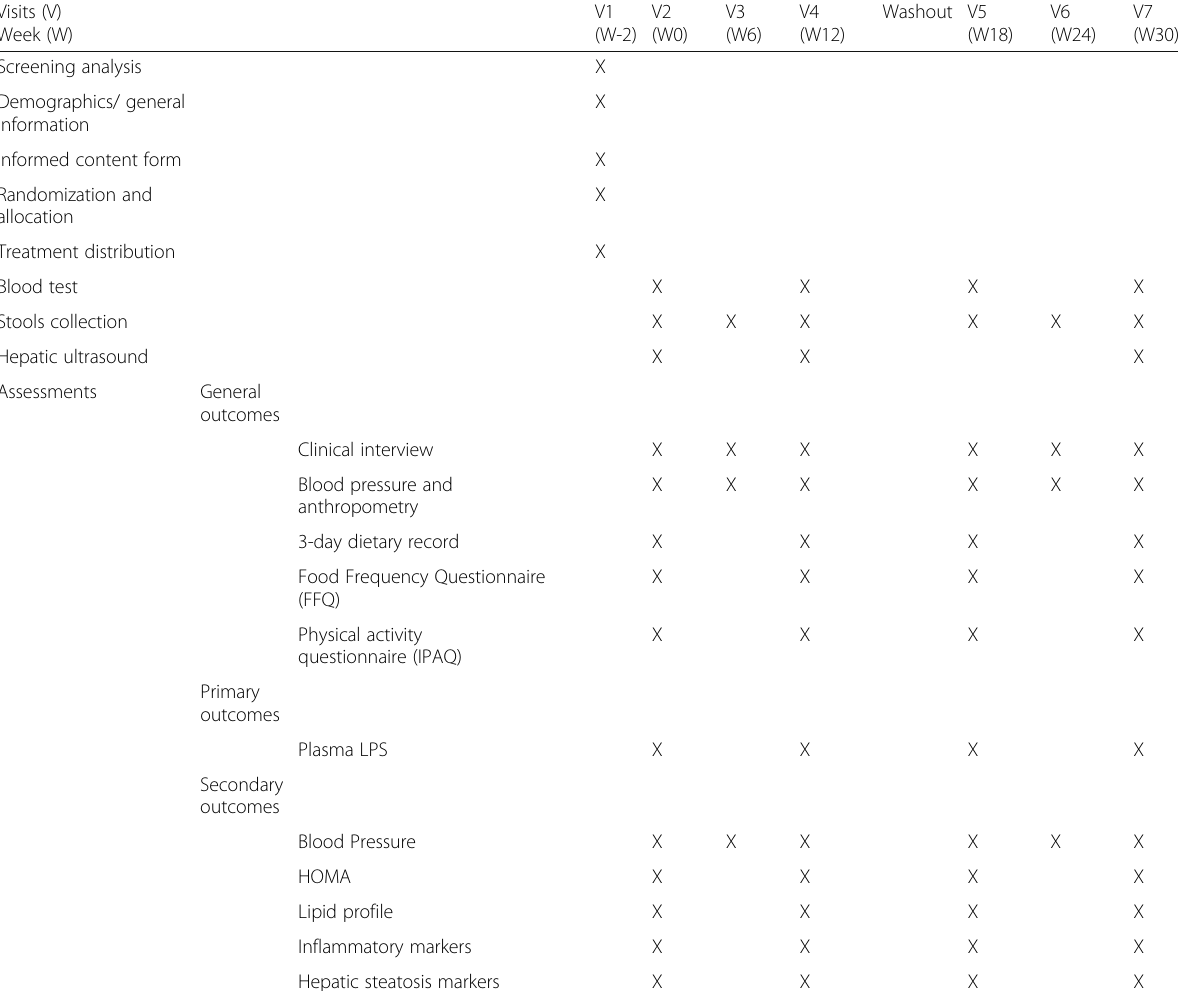
Table 1 Detailed study procedures Visits (V) Week (W)